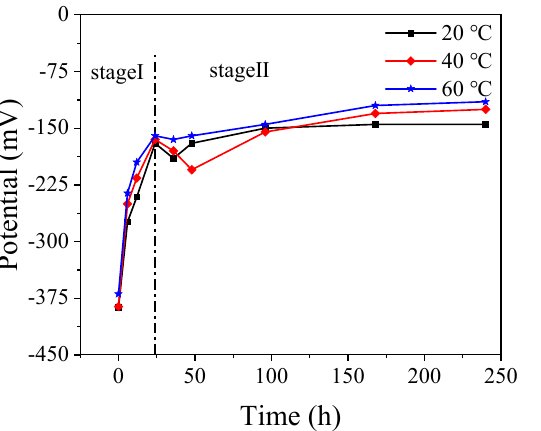
Figure 2. The OCP evolution of Q235 steel after passivation in SCP at various temperatures for a different time.